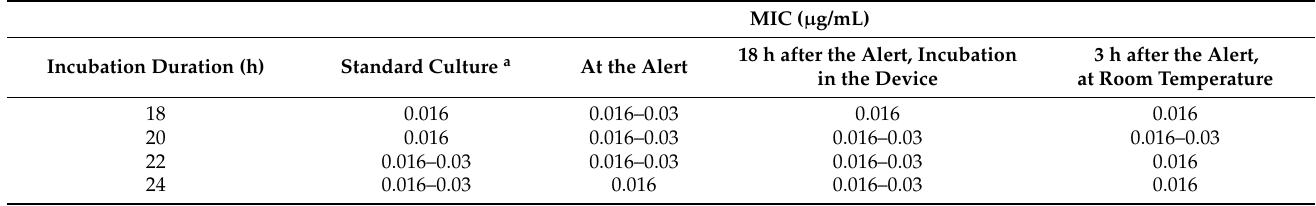
Table 11. Ciprofloxacin Etest MIC values of Y. pestis -positive blood cultures.